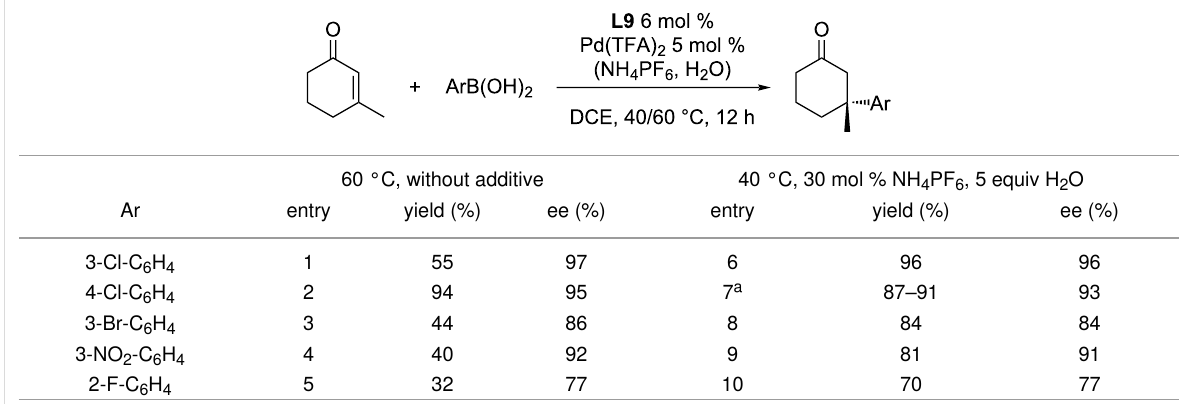
Table 19: Effect of ammonium hexafluorophosphate as additive on the addition reactions of arylboronic acids to 3-methyl-2-cyclohexanone catalysed by L9 /Pd(TFA) 2 [48,50].